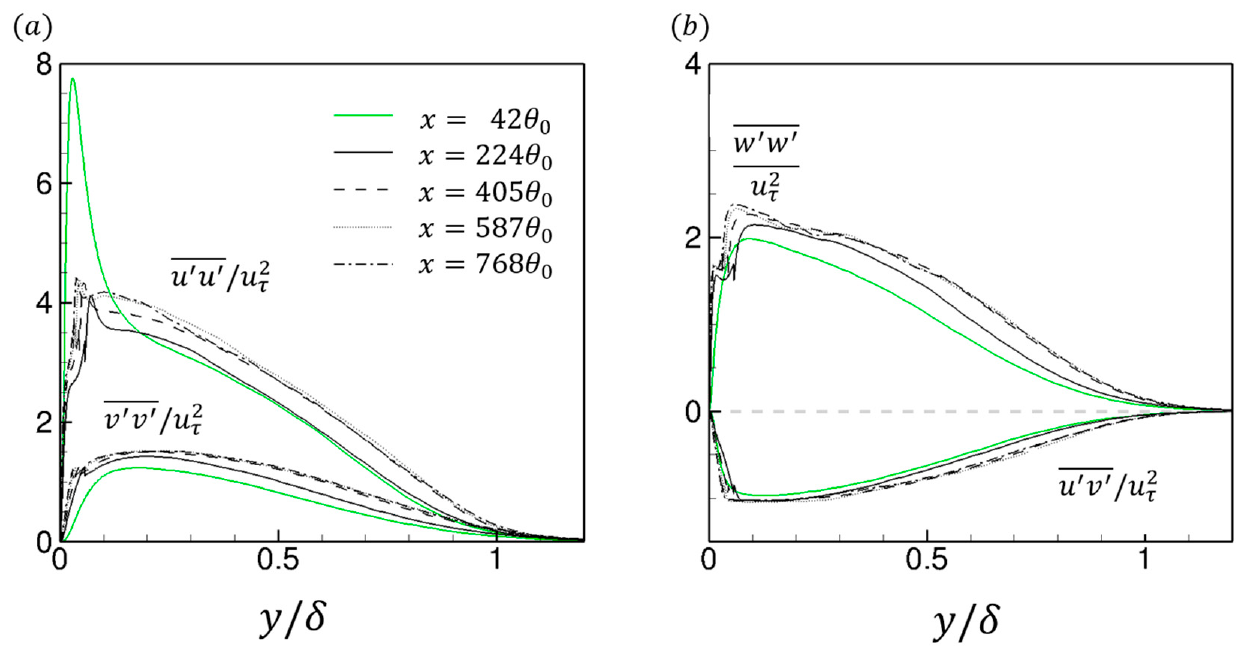
Figure 13. Wall-normal variation of inner-scaled turbulence stresses at different streamwise stations. The wall-normal distance y is normalized using the local TBL thickness δ . ( a ) Streamwise and wall-normal Reynolds stresses; ( b ) spanwise Reynolds stress and Reynolds shear stress.